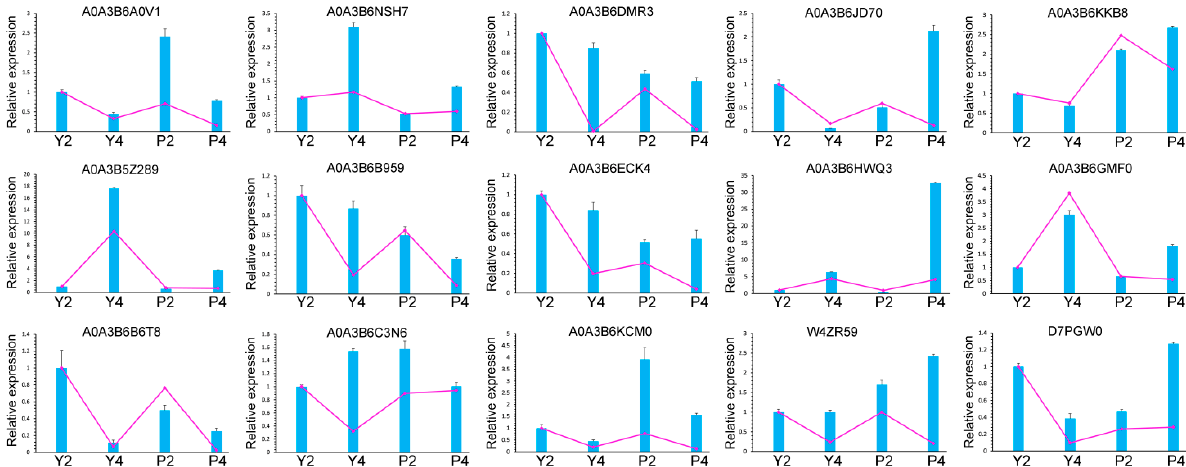
Figure 11. Cognate gene relative expression analysis of DEPs by qRT ‐ PCR. Histograms show protein expression level, whereas line charts show gene relative expression level. The data obtained on genes’ relative expression levels and proteins’ expression levels are the means based on three biological replicates. Y2, Y4, P2, and P4 represent anthers in stage 2, 4, respectively.